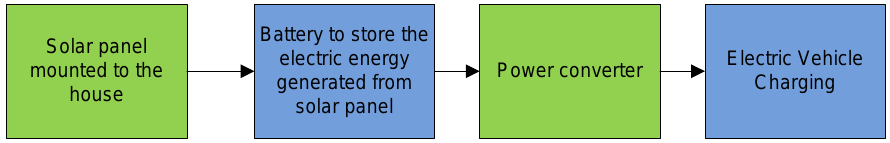
Figure 7. Solar panel and charging system for household purposes.